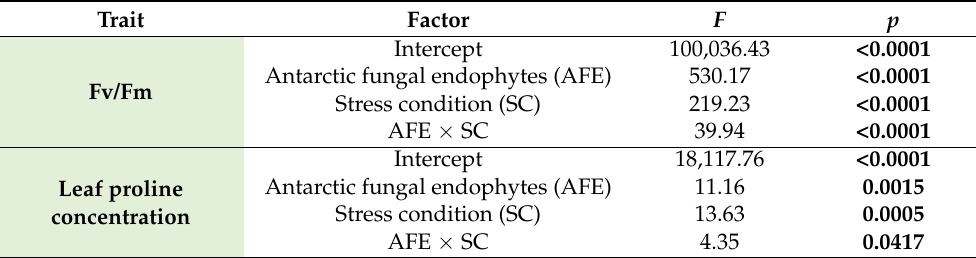
Table 1. Analysis of variance (ANOVA) on the fitted Linear Mixed-effects Models (LMM) evaluating the effects of the presence/absence of two Antarctic fungal endophytes (AFE+ or AFE − ) and Stress condition (cold without water deficit [Cold/W+] or cold and water deficit [Cold/W − ]) on three physiological (green) and one genetic (grey) trait variables of blueberry plants. Significant factor effects ( p < 0.05) are highlighted in